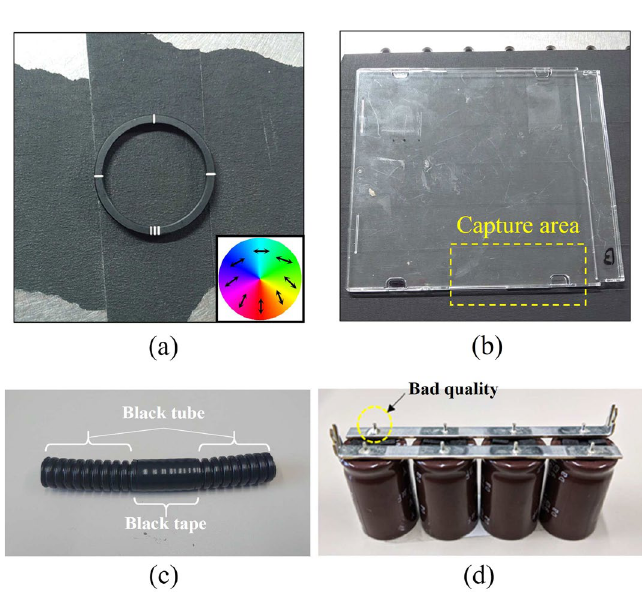
Figure 3. ( a – d ) the prepared samples. ( a ) Patterned retarder with a fast axis distribution that is illustrated on the lower right of the photograph. ( b ) CD case. ( c ) Black tube wrapped in black tape. ( d ) Soldered